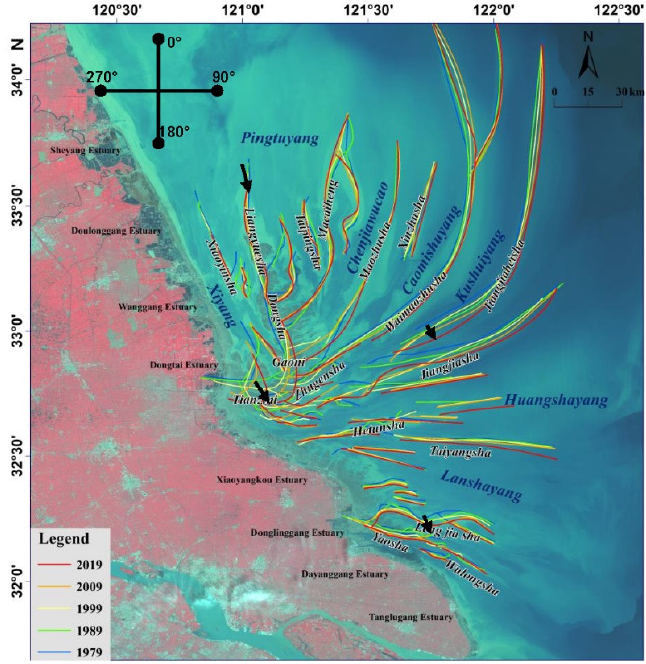
Figure 8. Spatial overlay map of sand ridge lines from 1979 to 2019.